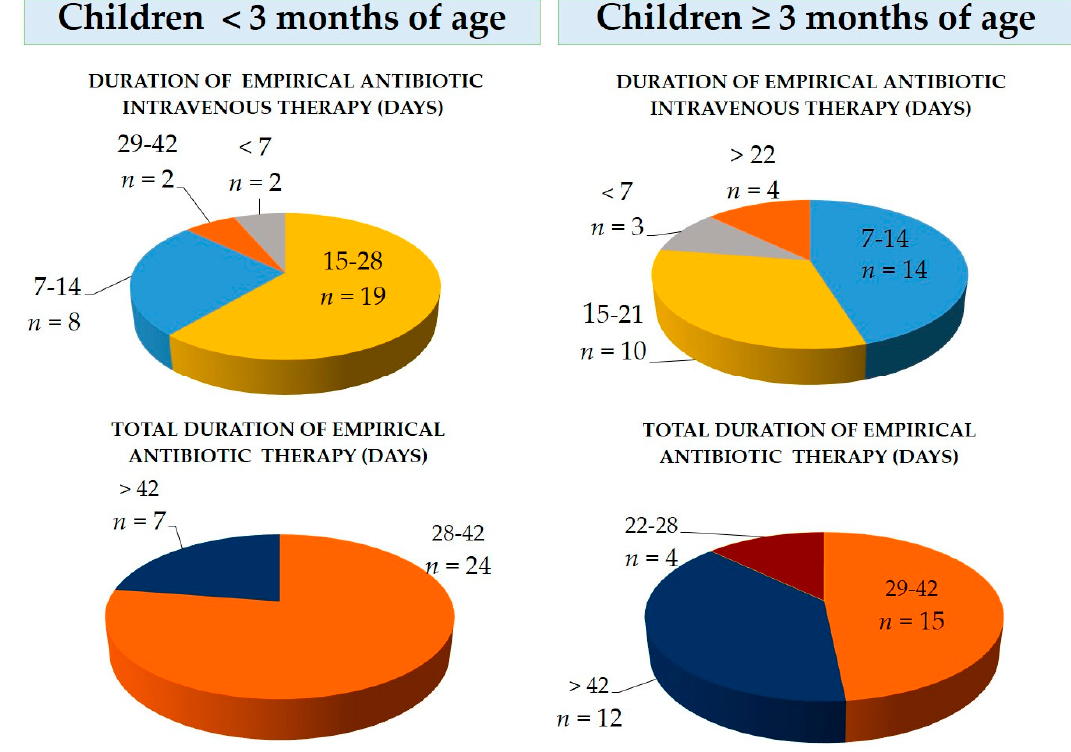
Figure 1. Duration of intravenous and total antibiotic therapy in 31 Italian pediatric clinics.